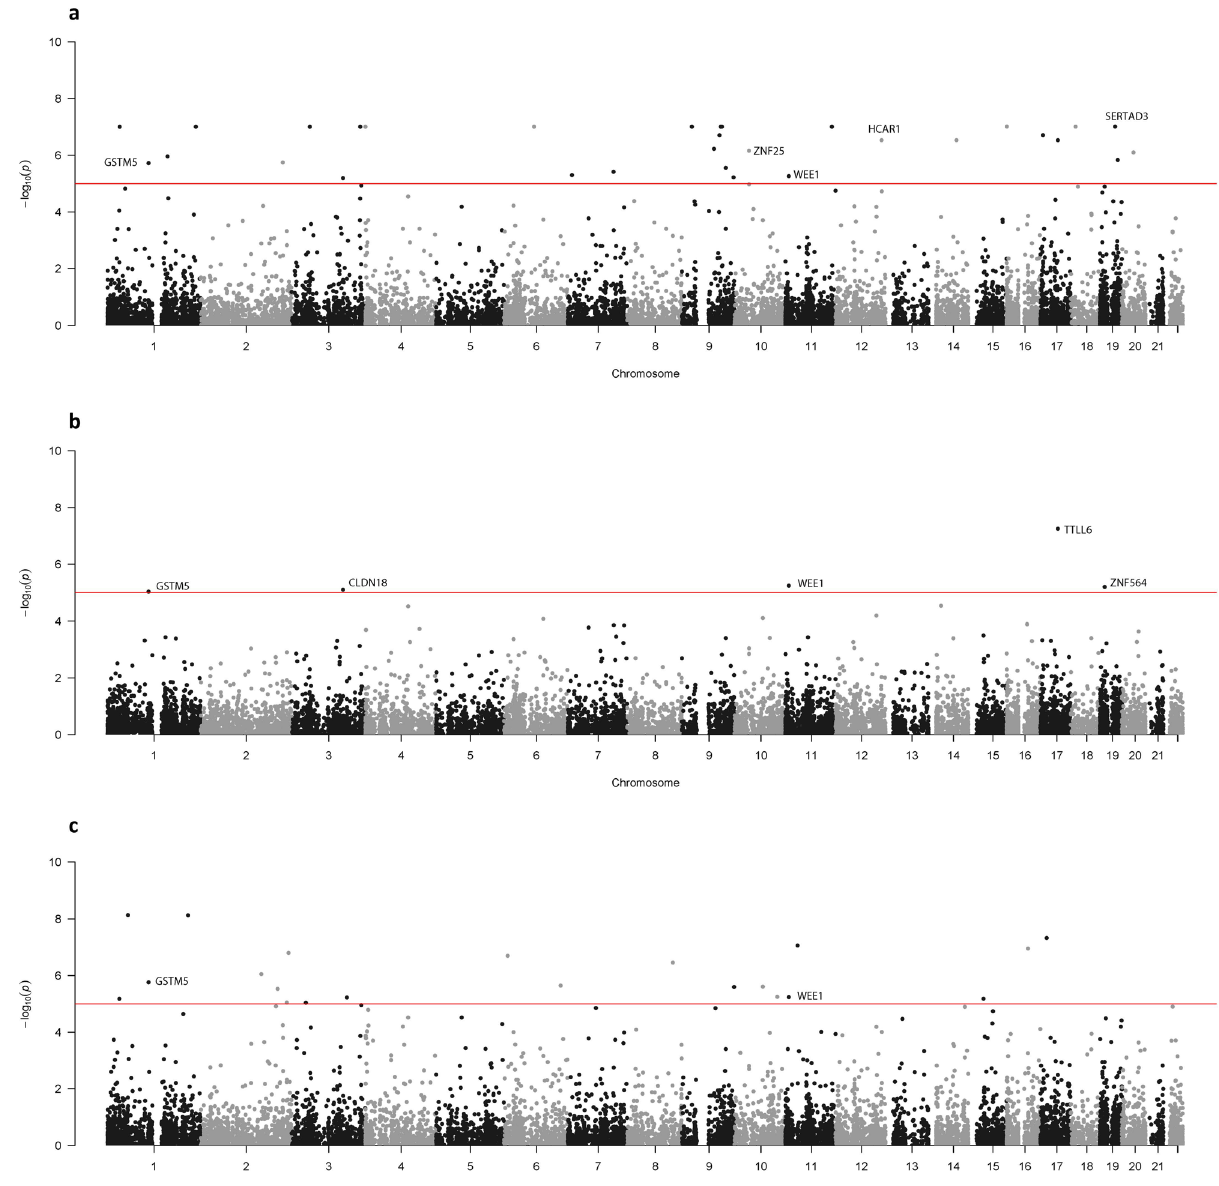
Fig. 5 P -values of the analysis using the Eastern Asian EACC only. The gene-based p -values of the EACC association analysis ( N = 4867) using the ( a ) EMMAX-VT test, ( b ) EMMAX-CMC test, and ( c ) ACAT. The line represents the genome-wide signi fi cant threshold of 1 ×10 − 5 . These plots are based on results in Supplementary Data 9 – 11